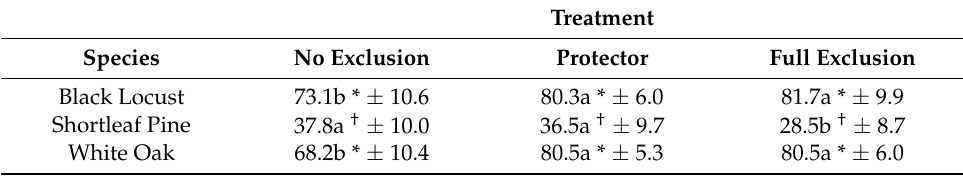
Table 2. First growing-season seedling survival (%; Mean ± SE) among tree species and exclusion treatments on reclaimed mined lands in southeastern KY. Means with differing letters indicate significant differences among exclusion treatments within a species, and means with different symbols indicate significant differences among species within an exclusion treatment, as determined via Type III ANOVA and subsequent Tukey-corrected pairwise comparisons at a 0.05 significance